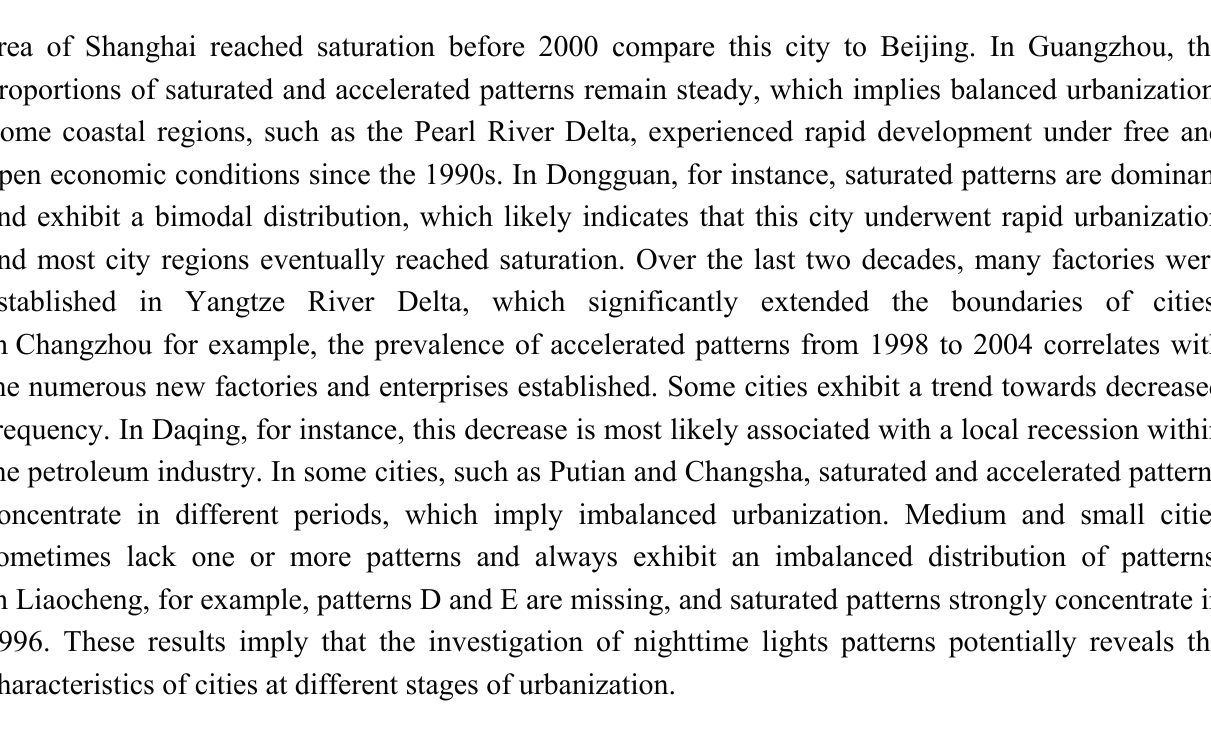
Figure 7. Diverse distributions of six patterns of nighttime lights in Chinese cities from 1994 to